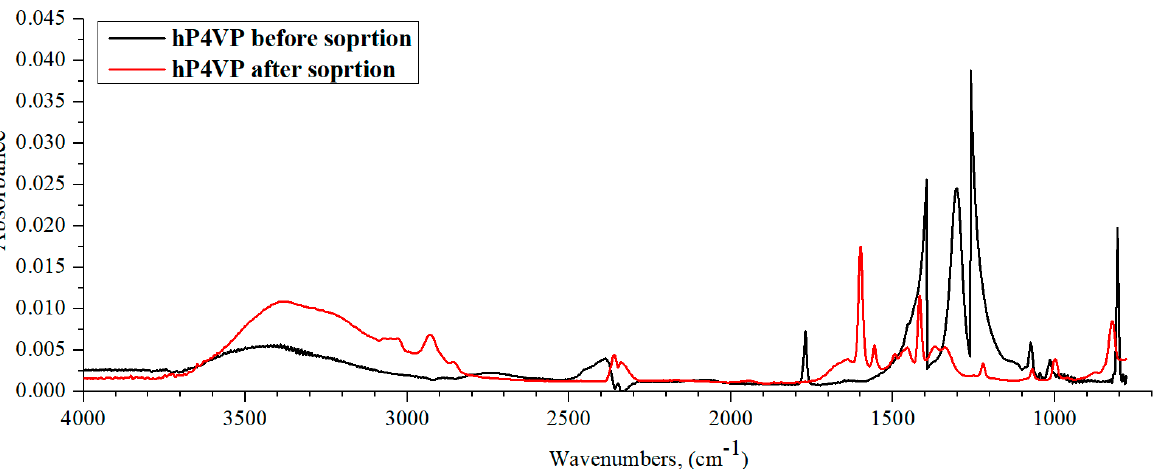
Figure 11. IR spectra of hP4VP before and after lanthanum sorption by interpolymer system 17%hPMAA-83%hP4VP.